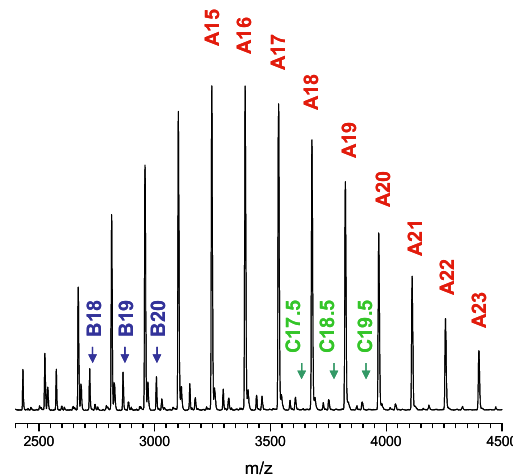
Figure 8. MALDI TOF spectrum of (iBu-POSS-S-PLLA)(7) hybrid obtained by polymerization of L,L -dilactide from (iBu-POSS-S-OH) catalyzed by tin (II) 2-ethylhexanoate, M n = 3600, PDI = 1.04.